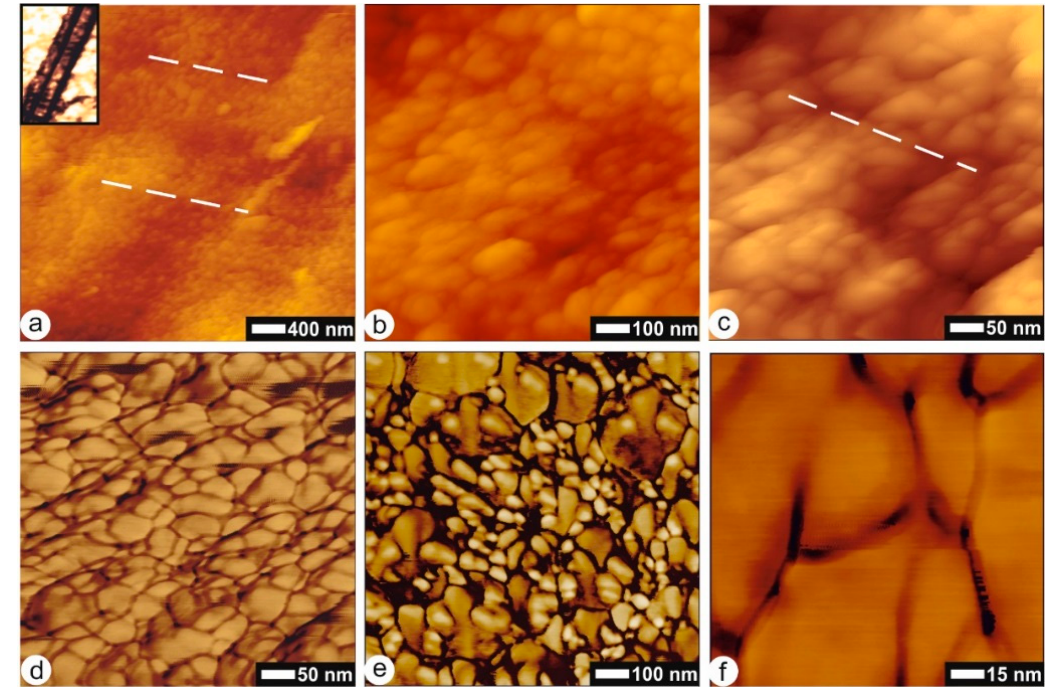
Figure 4. Pinna : Nanostructure of the lateral faces of prisms without the inter-prismatic membranes. ( a ) AFM height image shows a smooth surface: growth lines and granules are not distinct; insert: the isolated prism showing a striation on the lateral face. NaOCl for 1 h at 20 °C. ( b ) Detail of 4a, showing granules, the outlines of which are blurred; height image. ( c , d ) Detail of 4b; outlines are still blurred in height image (4c), but distinct in phase image (4d). ( e ) Same sample, other location; mineral granules do not show facets; phase image. ( f ) Granules are surrounded by a thin cortex; phase image.